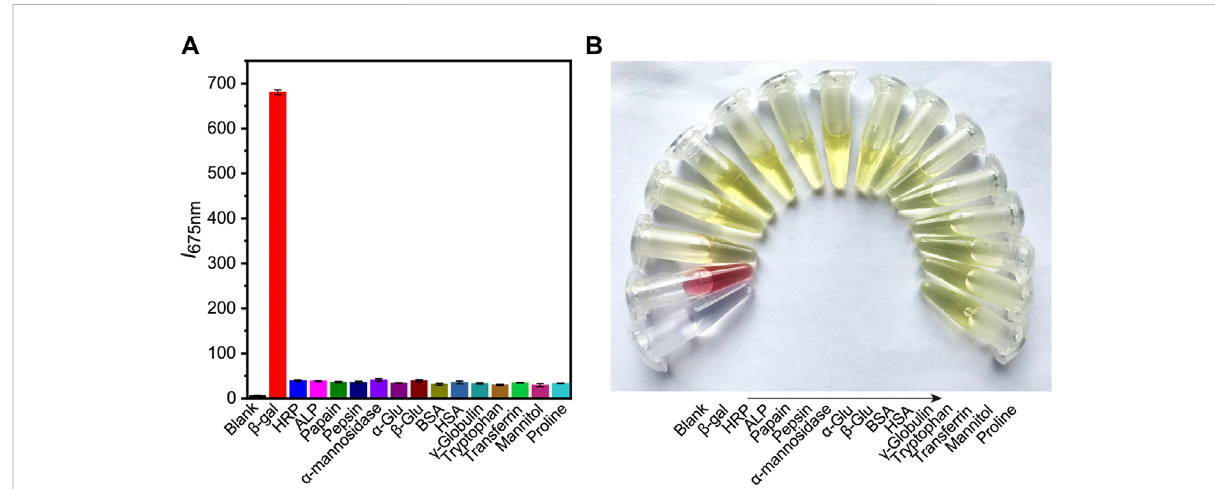
FIGURE 3 The selectivity of DCM- β gal towards of various biological species. Different types of biological samples are added into work solution of DCM- β gal and incubated at 37 ° C for 15 min. The fl uorescence intensity at 675 nm and colorimetric results of solution are then recorded. (A)